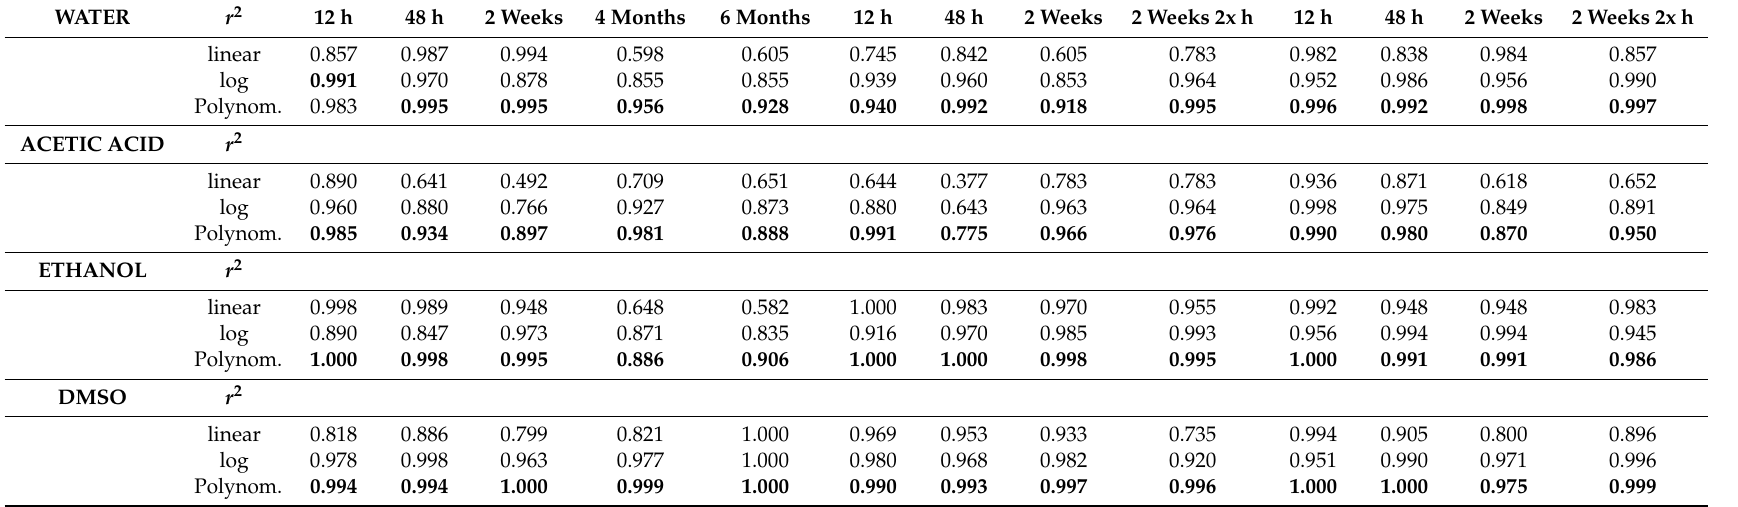
Table 1. Correlation coefficients for the models